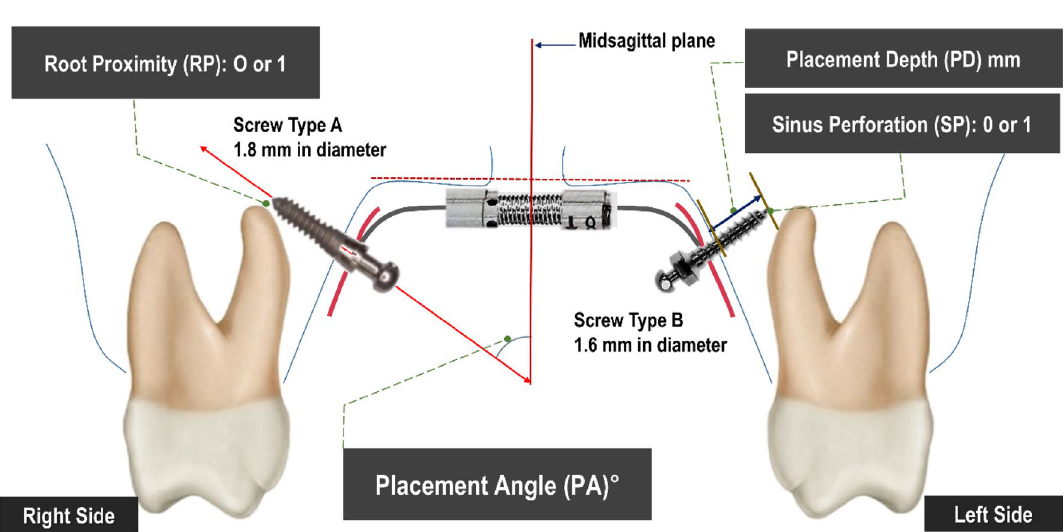
Figure 3. Schematic illustration of the measurements in this study. Screw Type A (C-implant; Cimplant Co, Seoul, Korea) was sand-blasted with a large-grit and acid etched (SLA) surface treated self-tapping miniscrew with a diameter of 1.8 mm and a length of 9.5 mm. Screw Type B (Bio-Action screw, Jin Biomed co., Bucheon, Korea) was a machined self-drilling miniscrew with a diameter of 1.6 mm and a length of 8.0